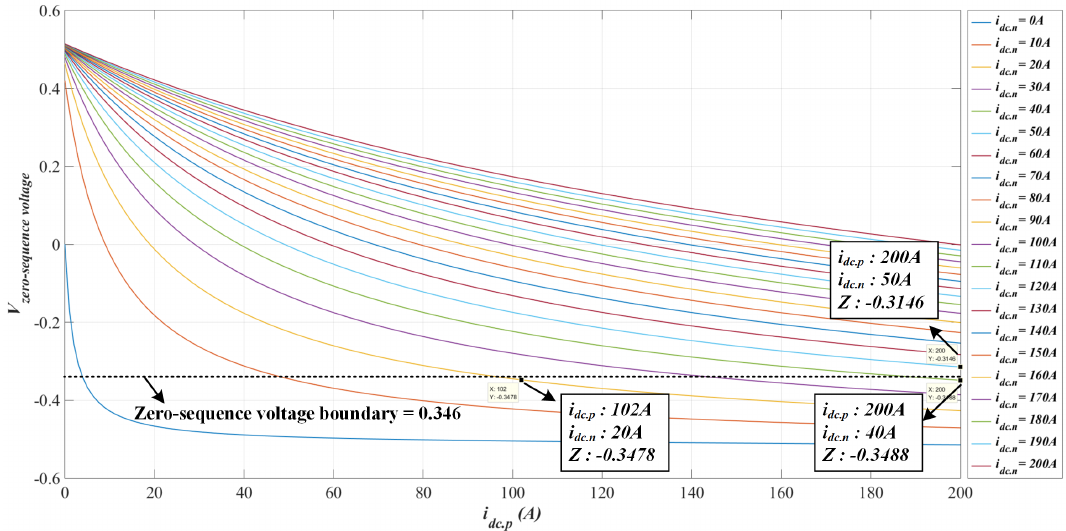
Figure 8. The required zero-sequence voltage for the load of the positive pole at constant load of the negative